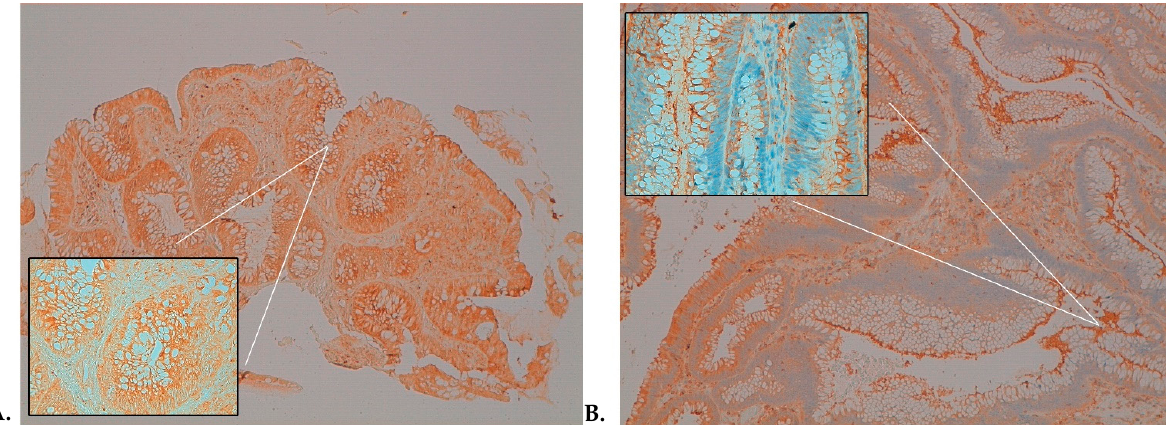
Figure 4. Immunohistochemistry (IHC) assessment of Ki-67 in high-grade dysplasia showing positive staining in 100% of cells in the pre-treatment sample ( A ) and 80% of cells post-treatment ( B ) (magnification: 10 × and 40 × in the box). Panels A and B are representative of the pre- and post-treatments from the same patient.